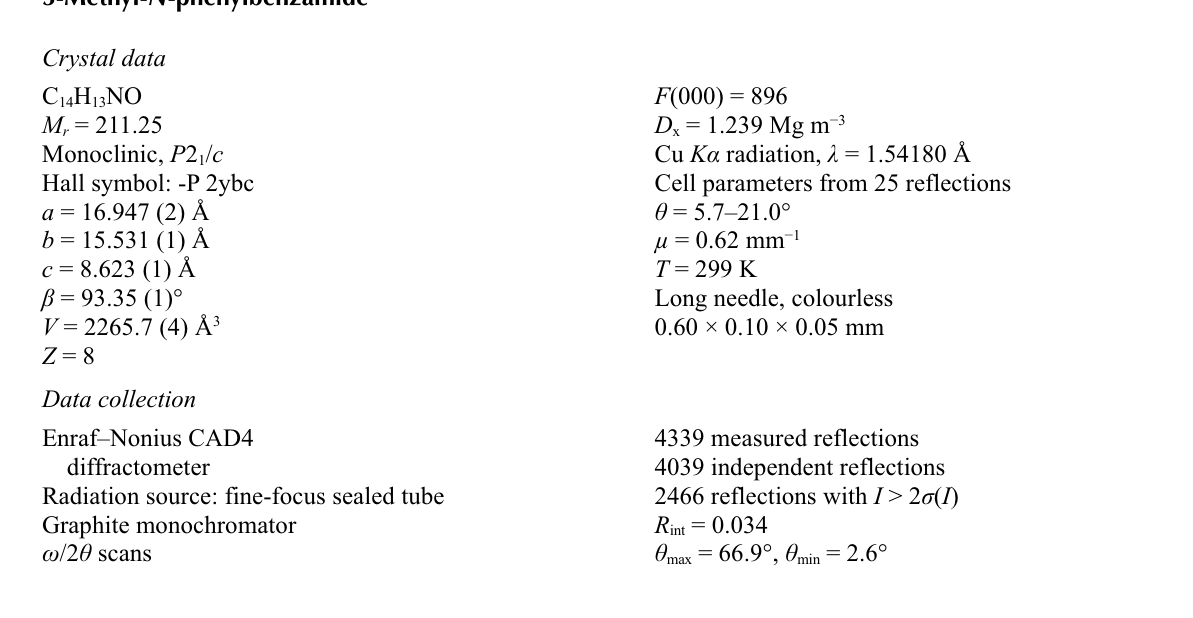
Molecular packing of the title compound with hydrogen bonding shown as dashed